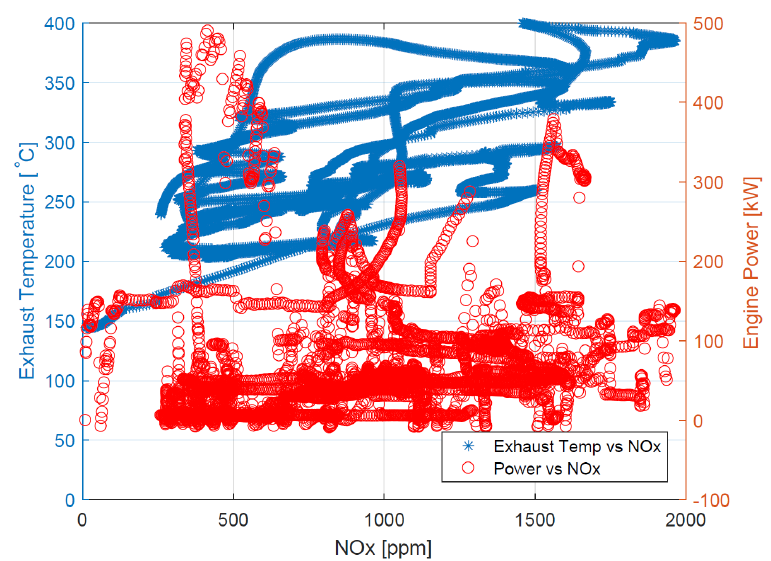
Figure 10. NOx emissions against power and exhaust